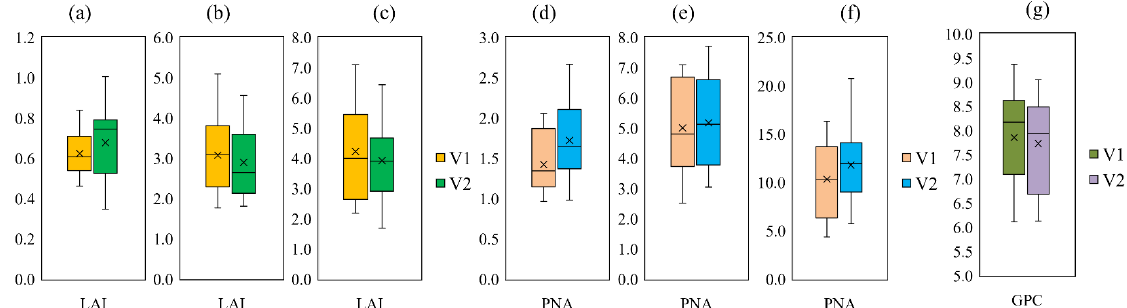
Figure 4. Data distribution box plots for leaf area index (LAI), plant nitrogen factor (PNA), and grain protein content (GPC) in rice varieties V1 (Meixiangzhan 2) and V2 (Wufengyou 615). LAI at ( a ) the tillering stage, ( b ) panicle initiation stage, and ( c ) heading stage; PNA at ( d ) the tillering stage, ( e ) panicle initiation stage, and ( f ) heading stage; and ( g ) GPC at the maturity stage.